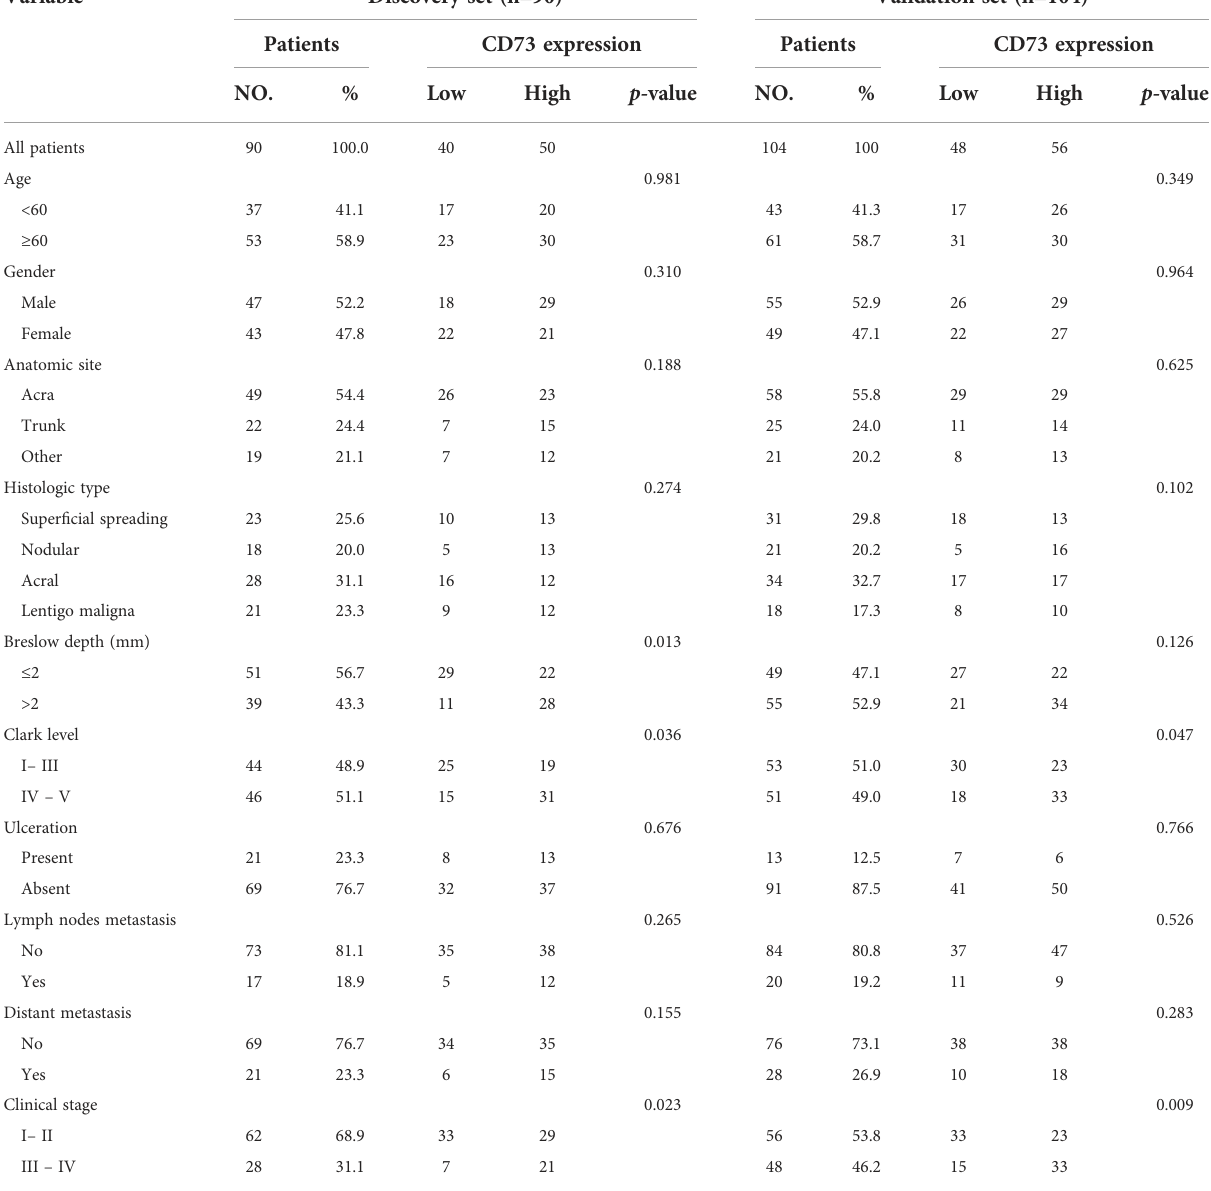
TABLE 1 Correlations between CD73 and baseline clinicopathologic features in melanoma patients.